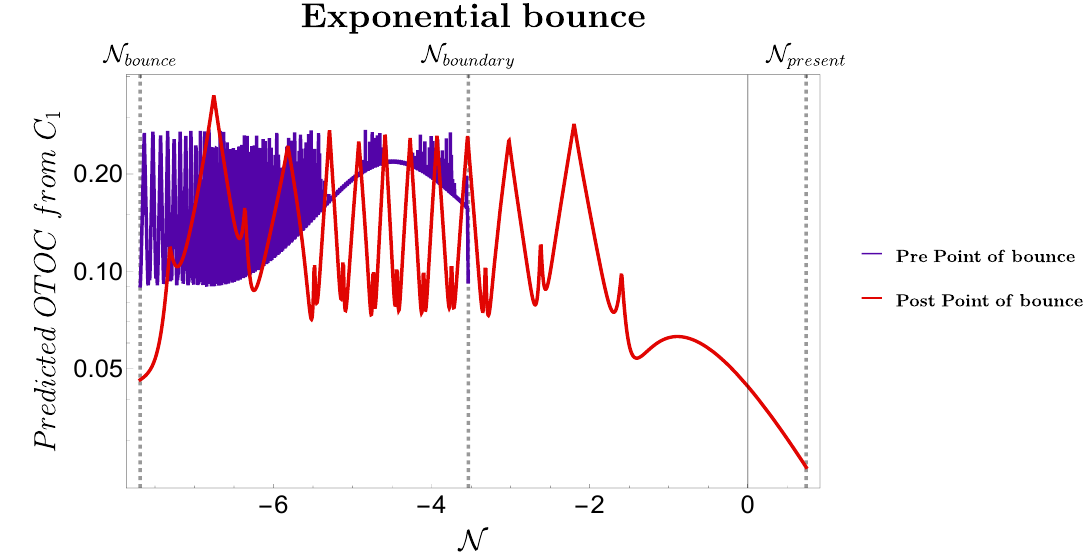
Figure 39: Predicted OTOC from linearly weighted complexity inside bouncing re- gion with respect to number of